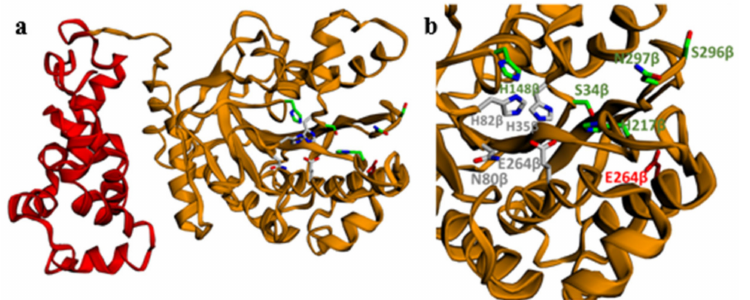
Figure 7. ( a ) The 3D structure of PcaA using homology modeling. Subunits α and β are colored in red and orange, respectively. Conserved residues H35 β , N80 β , H82 β , and E264 β are colored in gray and correspond to the iron-binding residues. The conserved residues S34 β , H148 β , H217 β , S296 β , and N297 β that can interact specifically with the aromatic ring of PCA are colored in green. The highly conserved aspartate residue D322 β is colored in red. ( b ) A closer view of subunit β with details on the conserved